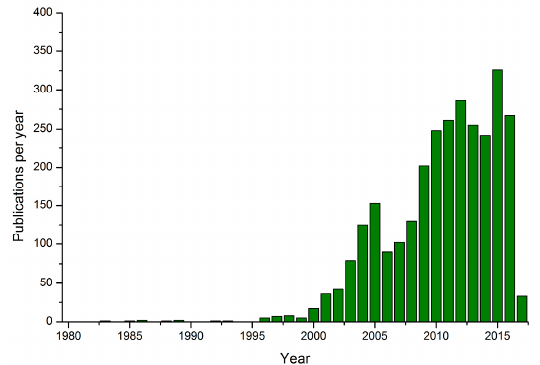
Figure 1. Increasing number of published papers from 1980 to 2017 in the Scopus Scholar database using “gold-based catalysts” and “environmental microscopy” as search keywords (March 2017).